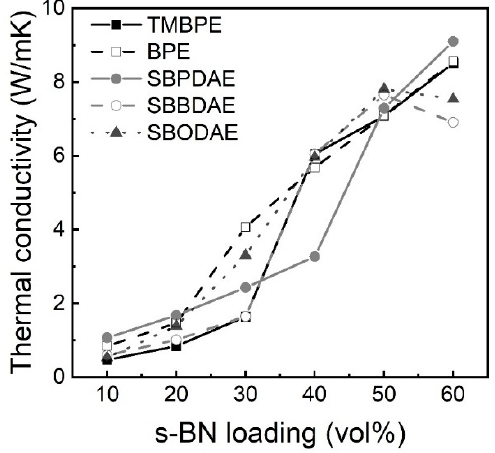
Figure 8. Thermal conductivity of five